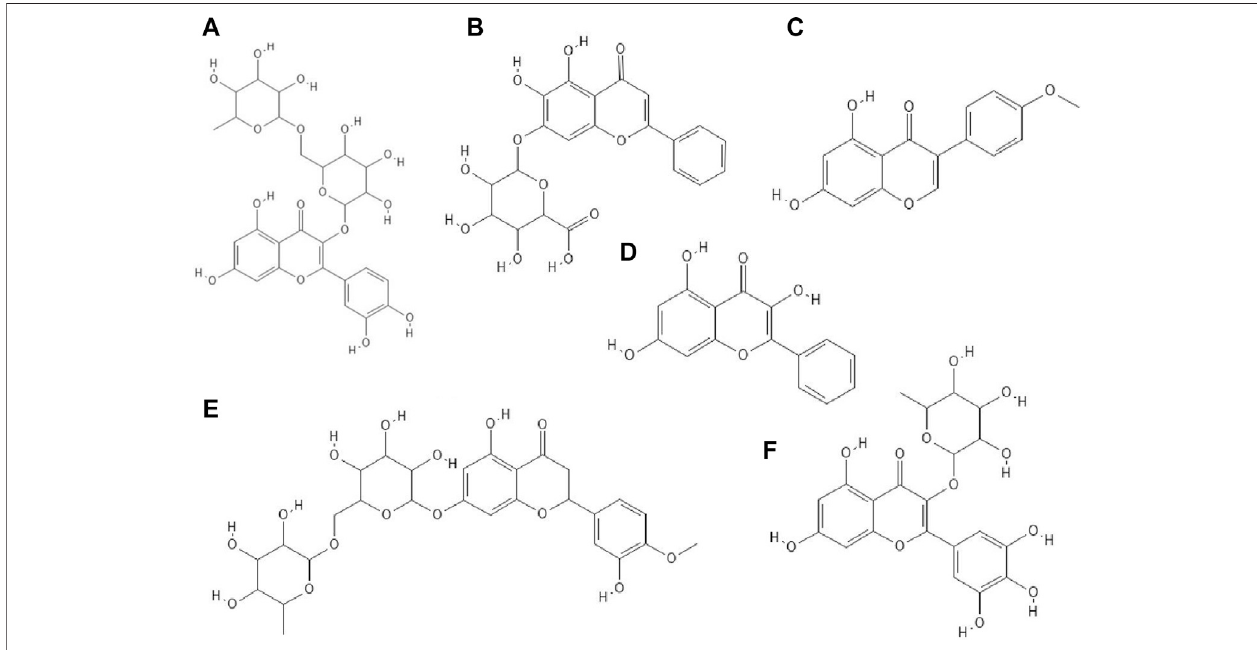
FIGURE 4 | The structures of: rutin (A) , baicalin (B) , biochanin A (C) , galangin (D) , hesperidin (E) , myricetin 3-rhamnoside (F) .